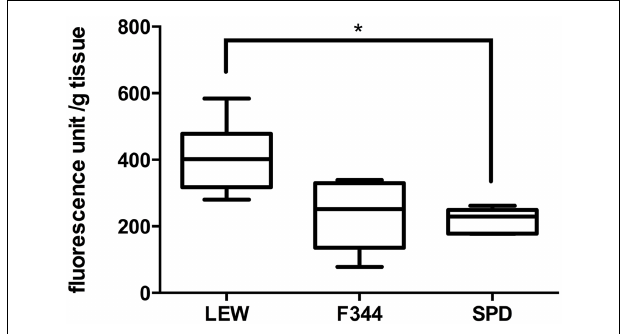
FIGURE 2 | Assessment of lipid peroxidation after severe SCI . SCI significantly increased LP in LEW rats in comparison to SPD but not F344. Boxes represent the distribution of the data ( n = 8/group), extending from the 25th to the 75th percentiles; the line is drawn at the median; whiskers represent the highest and lowest values. * P < 0.05. Kruskal–Wallis test with a post hoc Dunn’s multiple comparisons test.